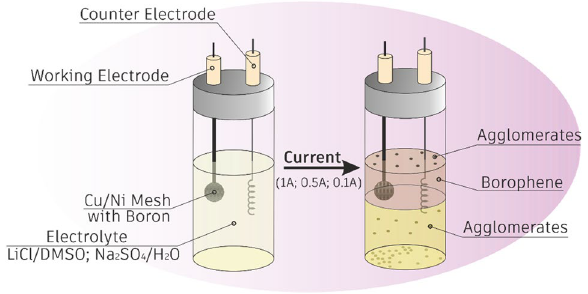
Figure 1. Schematic representation of the electrochemical exfoliation of